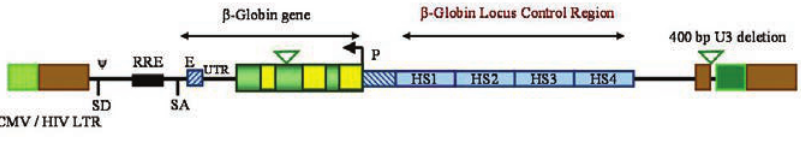
Figure 2. General scheme of a prototypical b -globin lentiviral self-inactivating vector. The vector consists of viral and human b -globin gene sequences. Viral sequences: viral packaging signal ( y ); donor (SD) and acceptor (SA) splicing sites; viral Rev responsive element (RRE). b -globin gene sequences: a combination of 2 to 4 core sequences from DNase hypersensitive (HS) sites (HS1, HS2, HS3, HS4); b -globin gene body including from 200 to 400 bp of promoter sequences (P); a stabilizing 372 bp RsaI deletion of IVS2 (RsaI); variable length of the 3’untraslated region (UTR); the enhancer region contained in a PstI fragment 3’ to the b -globin gene (E). Safety modifications include stop codons in the y signal and a 400 bp deletion in the U3 region of the 3’long terminal repeat